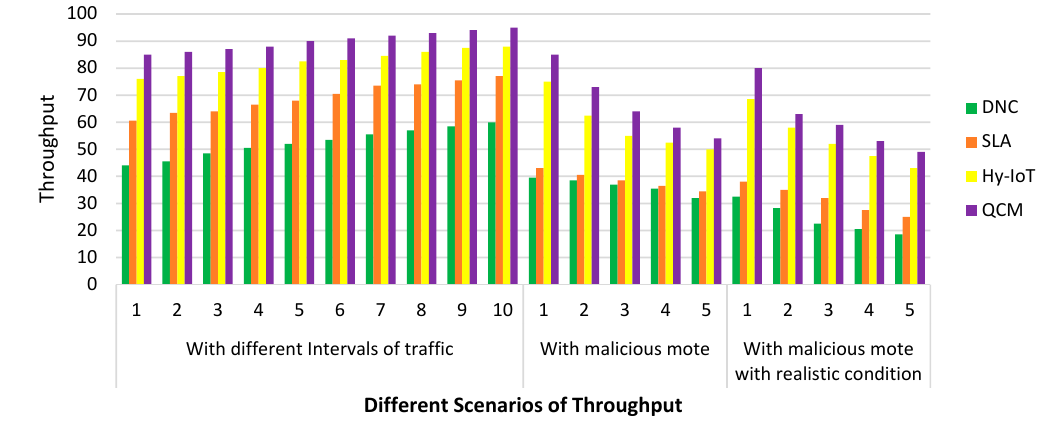
Figure 5. Throughput with different intervals of traffic.